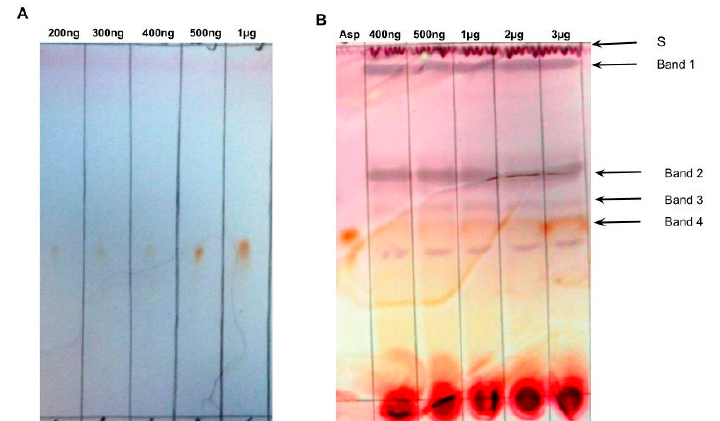
Figure 3. Lowest limit of detection for ( A ) pure aspalathin ( n = 9, 1 replicate shown), and ( B ) plant 3 (contains no aspalathin) spiked with different aspalathin concentrations ( n = 9, 1 replicate shown), using TLC. Asp: aspalathin standard, S: solvent